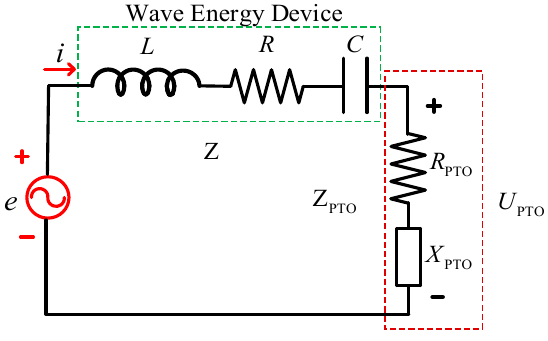
Figure 4. Equivalent electric model of the WEC.